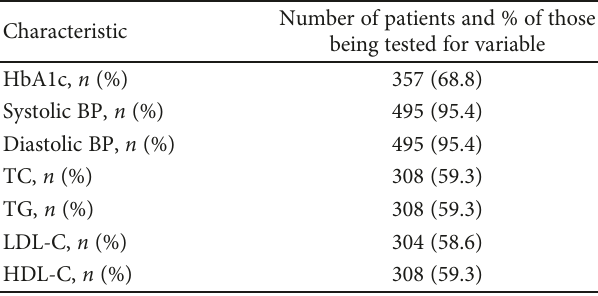
Table 3: Processes of care: measurements taken in patients with T2DM attending the Hillbrow Community Health Centre.